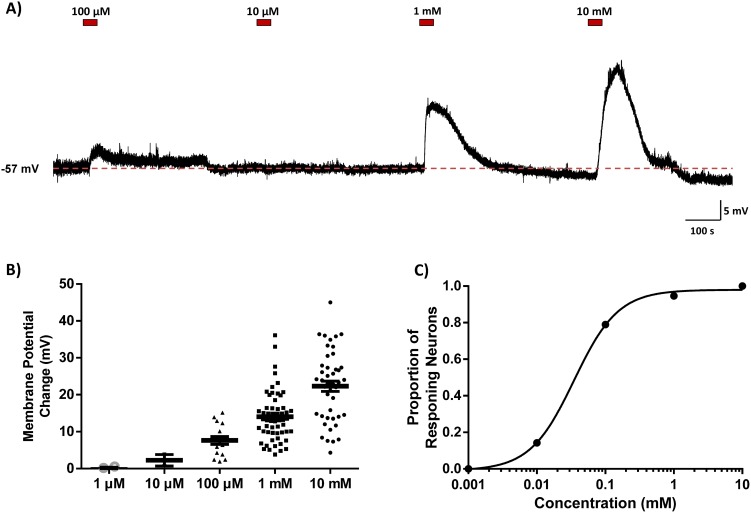
Hydrogen sulfide depolarizes neurons in a concentration-dependent manner.(A) Current clamp recording illustrating the concentration dependent effects of 4 different concentrations of NaHS (red bars indicate time of application) in a single SFO neuron. (B) Scatter plot indicating the membrane potential changes for all neurons recorded. Black bars indicate mean ± SEM. (C) NaHS concentration curve illustrating proportion of responding neurons at each concentration, EC50 = 35.6 µM.